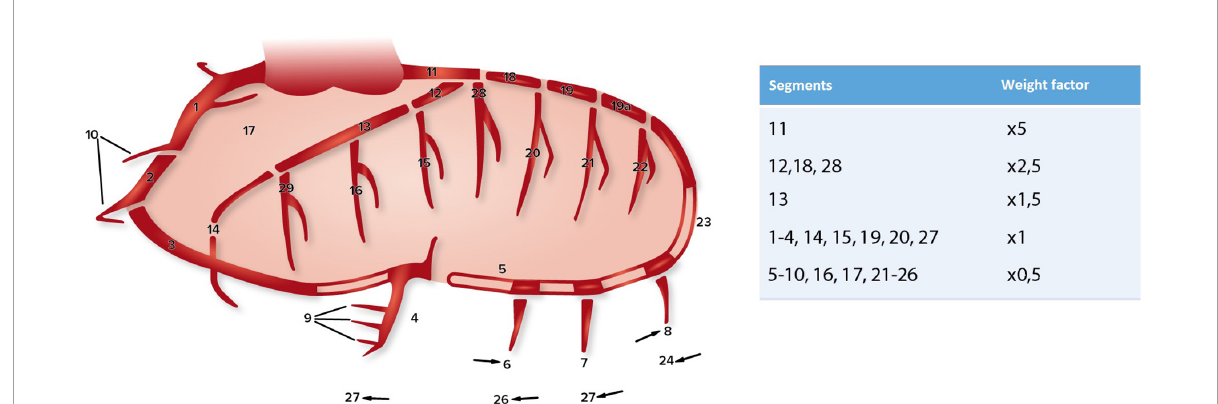
FIGURE1 Coronary artery segments (according to CASS) and the corresponding weight factors used for the CAGE score, adapted from Scanlon et al. (20), Vlietstra et al. (21), and Emond et al. (22).